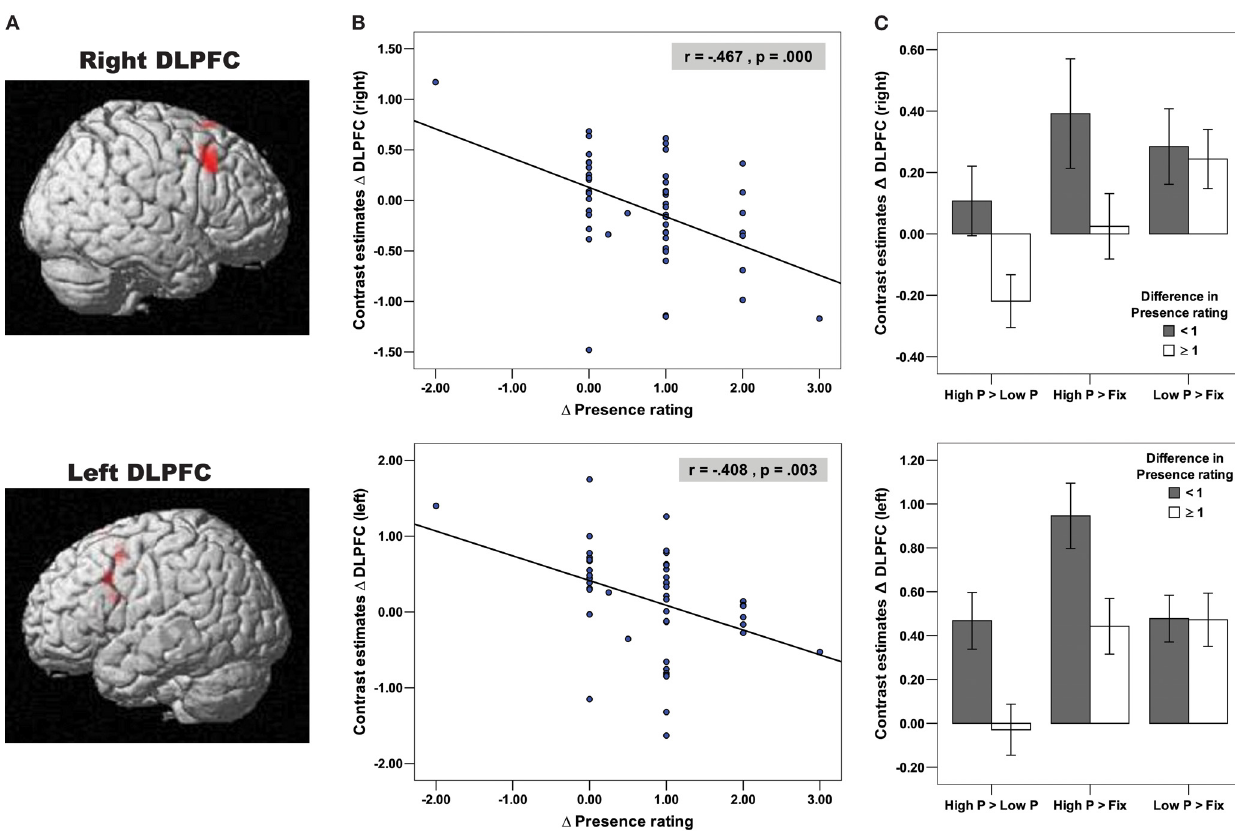
Figure 2 | Negative correlation of bilateral DLPFC with Presence experience in adults. (A) Depicted on the brain images are the bilateral DLPFC (right: x = 48, y = 21, z = 39; BA = 9; left: x = − 54, y = 15, z = 36, BA = 9), which negatively correlated with the presence rating in adult subjects, indicating that the High Presence condition yielded a greater activation increase in the bilateral DLPFC in adult subjects who reported a smaller amount of Presence elevation between the High and Low Presence condition. (B) These negative correlations of DLPFC and presence ratings are depicted on the two scatter plots using functional ROIs. (C) In order to examine whether DLPFC activation differences in the High Presence (as expected), Low Presence or in both conditions con- tributed to the negative correlational pattern, we extracted contrast estimates difference in the bilateral DLPFC for the contrasts Low P > Fix, High P > Fix and High P > Low P (High P = High Presence, Low P = Low Presence and Fix = Fixation Baseline). Based on these contrast estimates, we created bar plots, broken down for adult subjects with difference in Presence rating < or ≥ 1, referred to as low and high Presence rating group, respectively. These bar plots illustrated that there is no difference in DLPFC activation between the two rating groups during the Low Presence condition (independent t -tests for right DLPFC: t = 0.26, df = 50, p = 0.793 and left DLPFC: t = 0.02, df = 50, p = 0.977). In contrast, during the High Presence condition, the low Presence rating group showed an increase, while the high Presence rating group showed no change (left DLPFC) or even a decrease in DLPFC (right DLPFC) activation, resulting in a signifi cant group difference in the High Presence condition (independent t -tests for right DLPFC (one-tailed): t = 1.87, df = 50, p = 0.033 and left DLPFC: t = 2.54, df = 50, p = 0.014). The rating groups signifi cantly differed therefore in the contrast High P > Low P for the right (independent t -test: t = 2.32, df = 50, p = 0.024) and the left DLPFC (independent t -test: t = 2.80, df = 50, p =